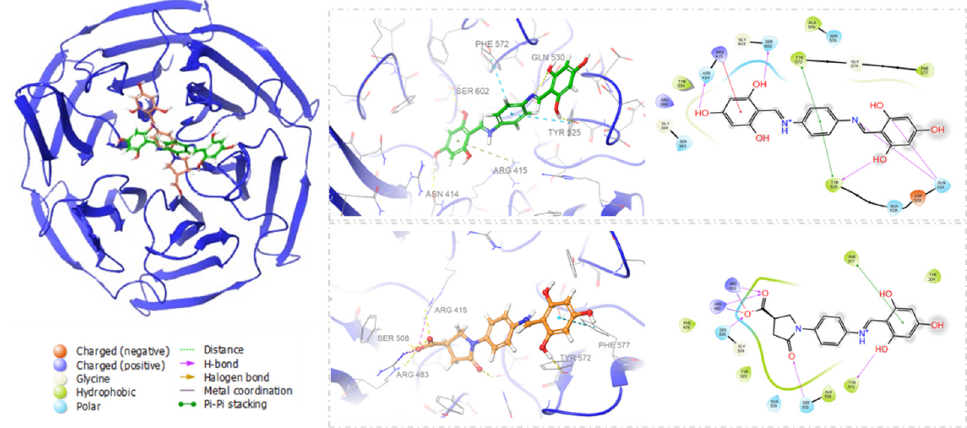
Figure 2. Docking pose of SH-29 (green) and SK-119 (orange) and their amino acid interactions with the binding site of Keap1. Ligands are represented in ball and stick.